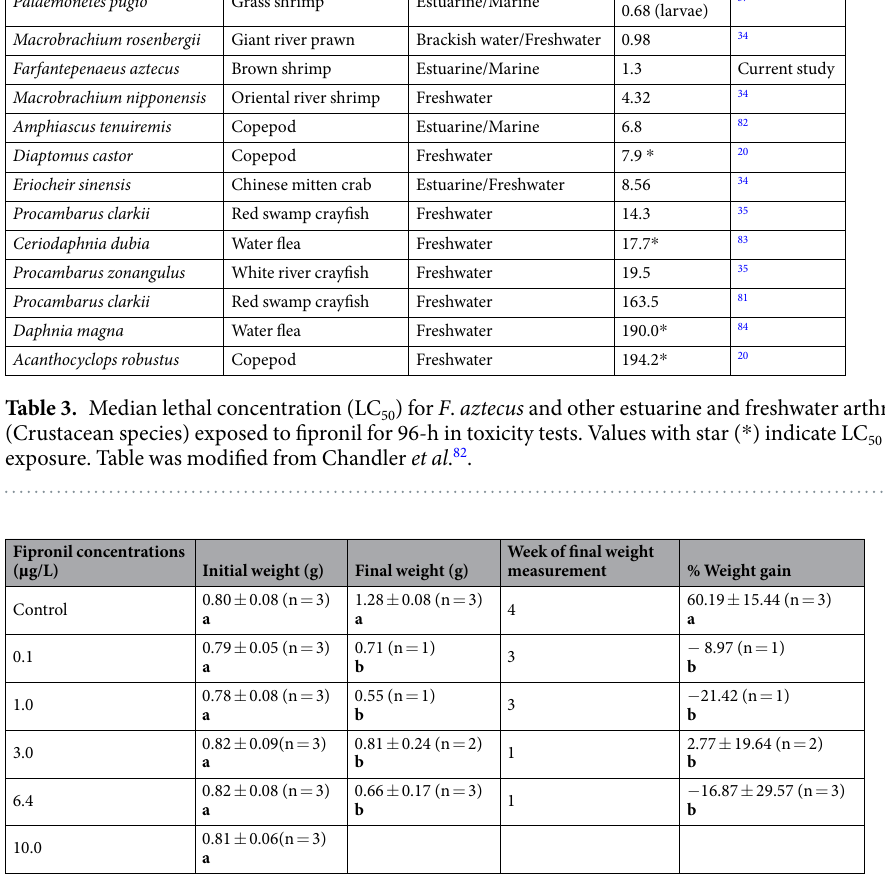
Table 4. Initial weight (g), final weight (g), and % weight gain (mean ± standard deviation) of juvenile shrimp exposed to different concentrations of fipronil. n = number of replicates in each treatment. All values were calculated based on the wet weight per individual shrimp. Means in columns not sharing the same letter are significantly different (P <